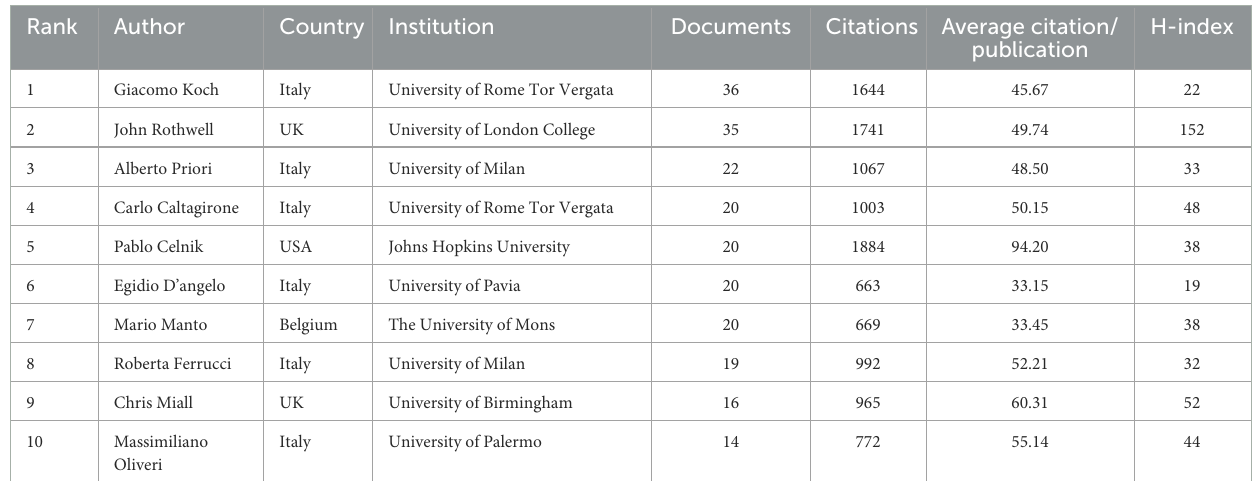
TABLE 3 Top 10 active authors on NICS